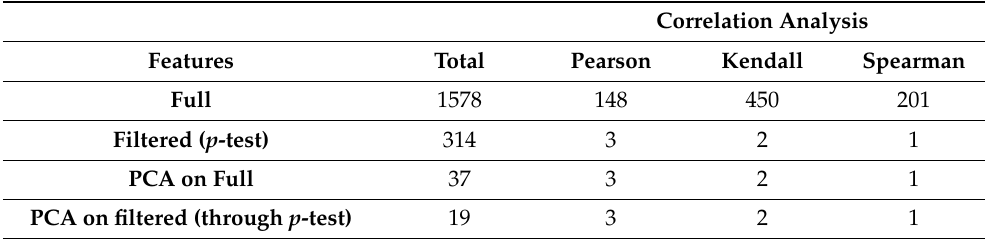
Table 5. Calculated features and correlation analysis results.